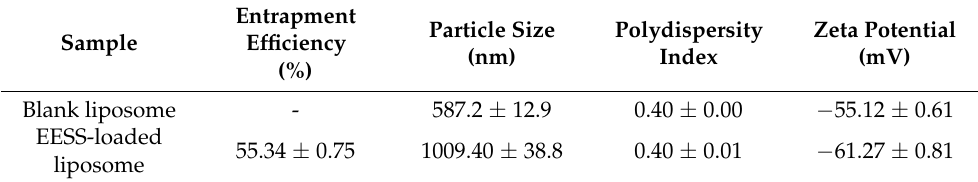
Table 2. Encapsulation efficiency, particle size, polydispersity index and zeta potential of liposome prepared using thin-film hydration method loaded with ethanolic extract from shrimp shell. Data were expressed as mean ± SD ( n = 3).